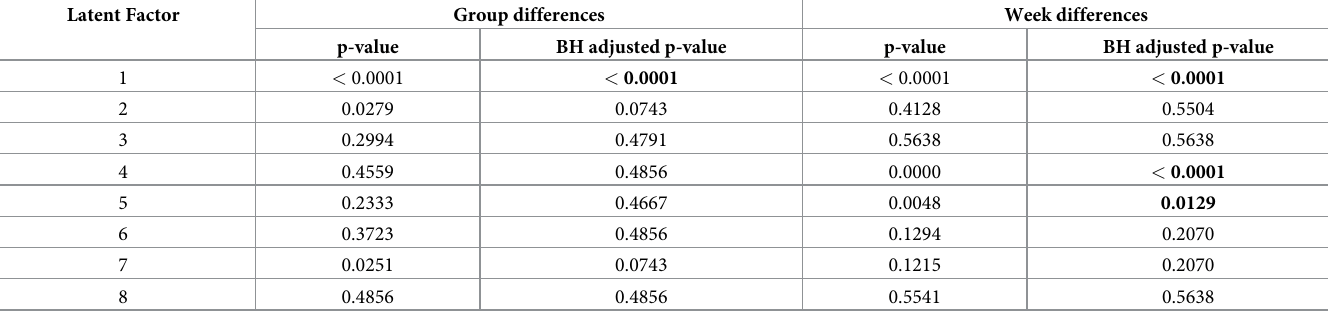
Table 3. P-values and adjusted p-values for the F test of no difference in the mean of each LF between mouse groups and week. Latent Factor Group